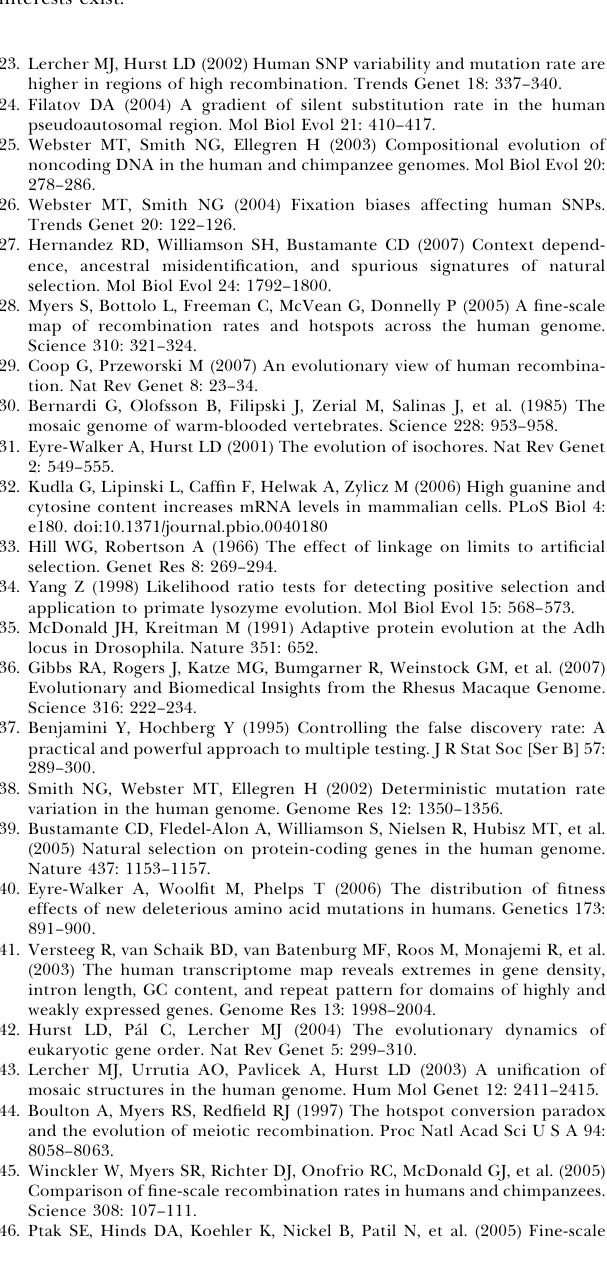
Table S2. LRT for Accelerated d N /d S on Human Branch Compared with Constant d N /d S across the Tree for All Genes Found at doi:10.1371/journal.pbio.1000026.st002 (327 KB